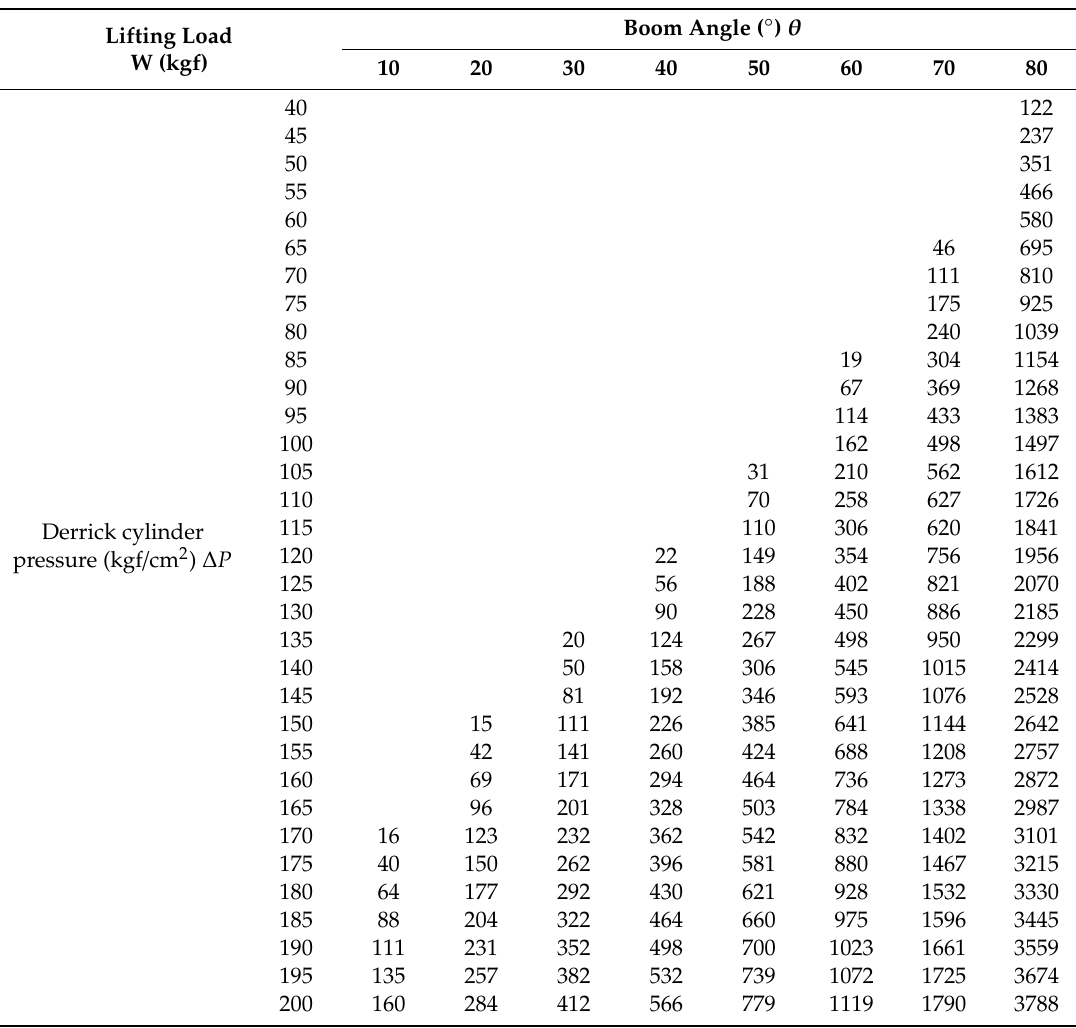
Table 3. Lifting load table for the AML control of a midsize cargo crane (7.5